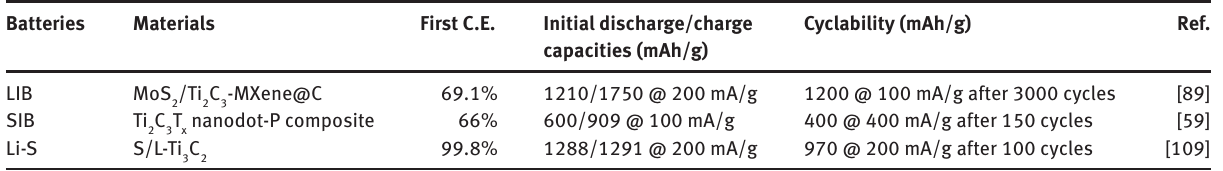
Table 2: Comparison of performance of batteries with MXene-based electrodes. Batteries